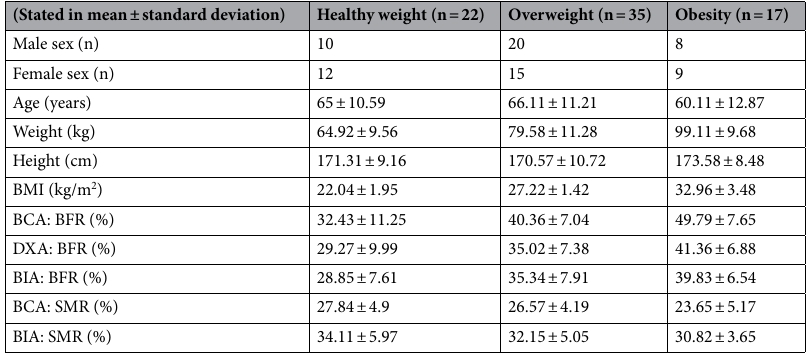
Table 1. Patient characteristics and results of body composition measurement assessed by BCA, DXA and BIA (n =